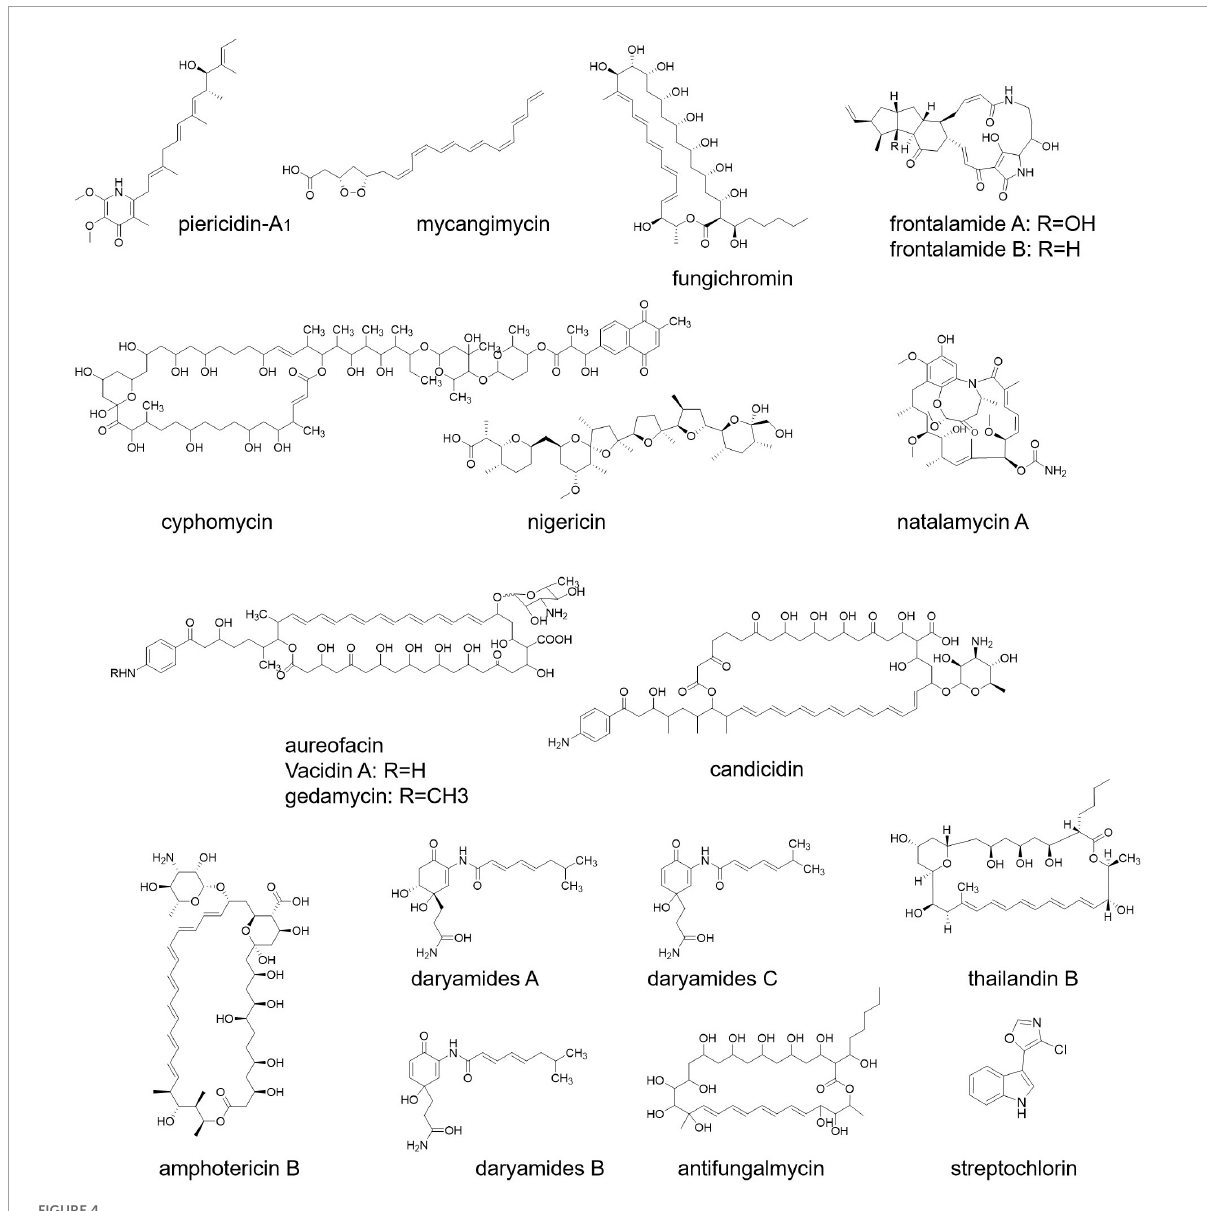
FIGURE4 Antifungal compounds from Streptomyces